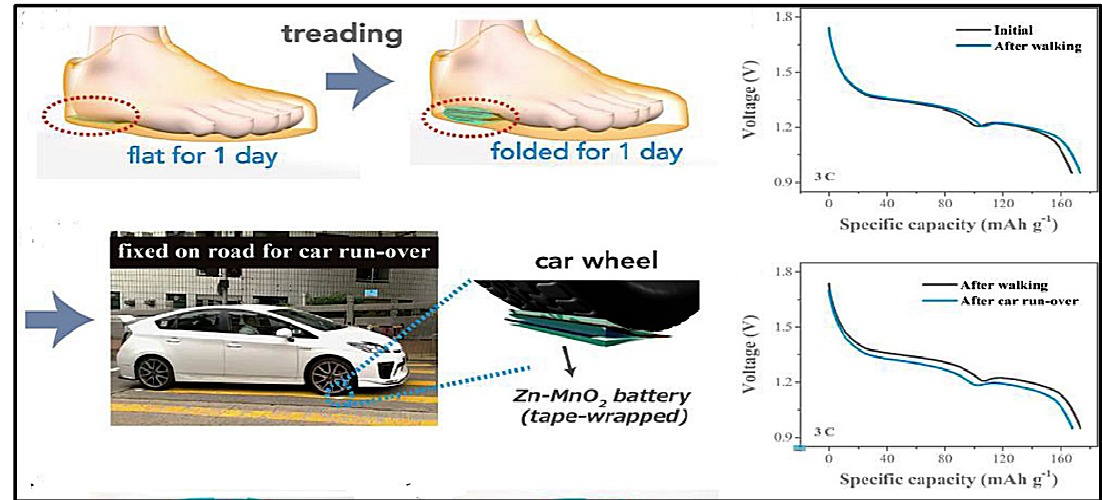
Figure 8. Illustrations of the Zn-MnO 2 battery being placed under foot and going through car run-over and discharge curves of the battery after 2 days’ everyday treading and after 20 times of random run-over by cars on road. All the discharge curves were recorded at 0.924 Ag − 1 (3C rate). Reproduced with permission from [154]. Copyright 2018 Elsevier.